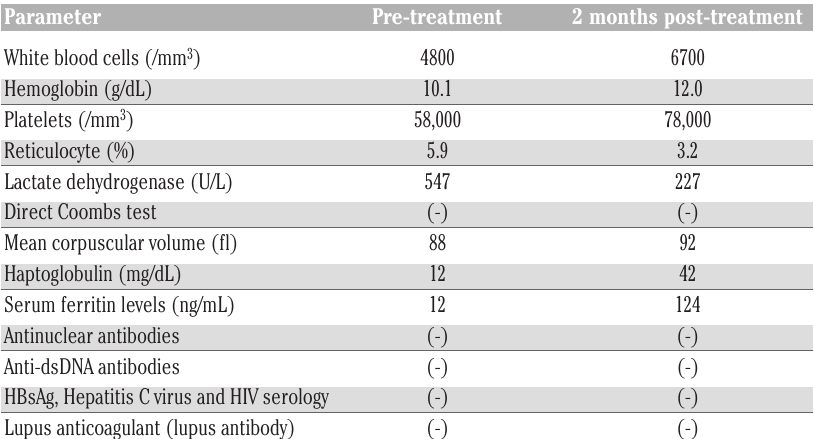
Table 1. Laboratory results of the patient before and after Eculizumab treatment.